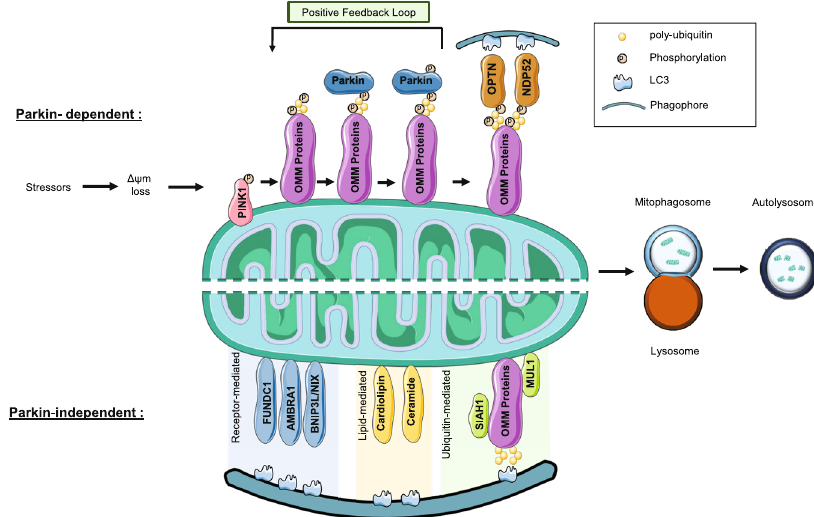
Fig. 1 Primary mechanisms of Parkin-dependent and Parkin-independent mitophagy. In Parkin-dependent mitophagy, PINK1 is stabilized to the OMM and autophosphorylated following mitochondrial depolarization. This is followed by the phosphorylation of ubiquitin and Parkin, with Parkin being recruited towards OMM and activated, leading to the broad ubiquitination of OMM substrates. Mitophagy is executed via autophagy receptor proteins (OPTN, NPD52) which link the impaired mitochondria to autophagosome. In Parkin-independent mitophagy, this linking of mitochondria to autophagosome is achieved in the absence of Parkin, with three pathways and their key players, including but not limited to: receptor-mediated mitophagy (FUNDC1, AMBRA1, BNIP3/NIX), lipid-mediated mitophagy (Cardiolipin, Ceramide), and ubiquitin- mediated mitophagy (SIAH1,